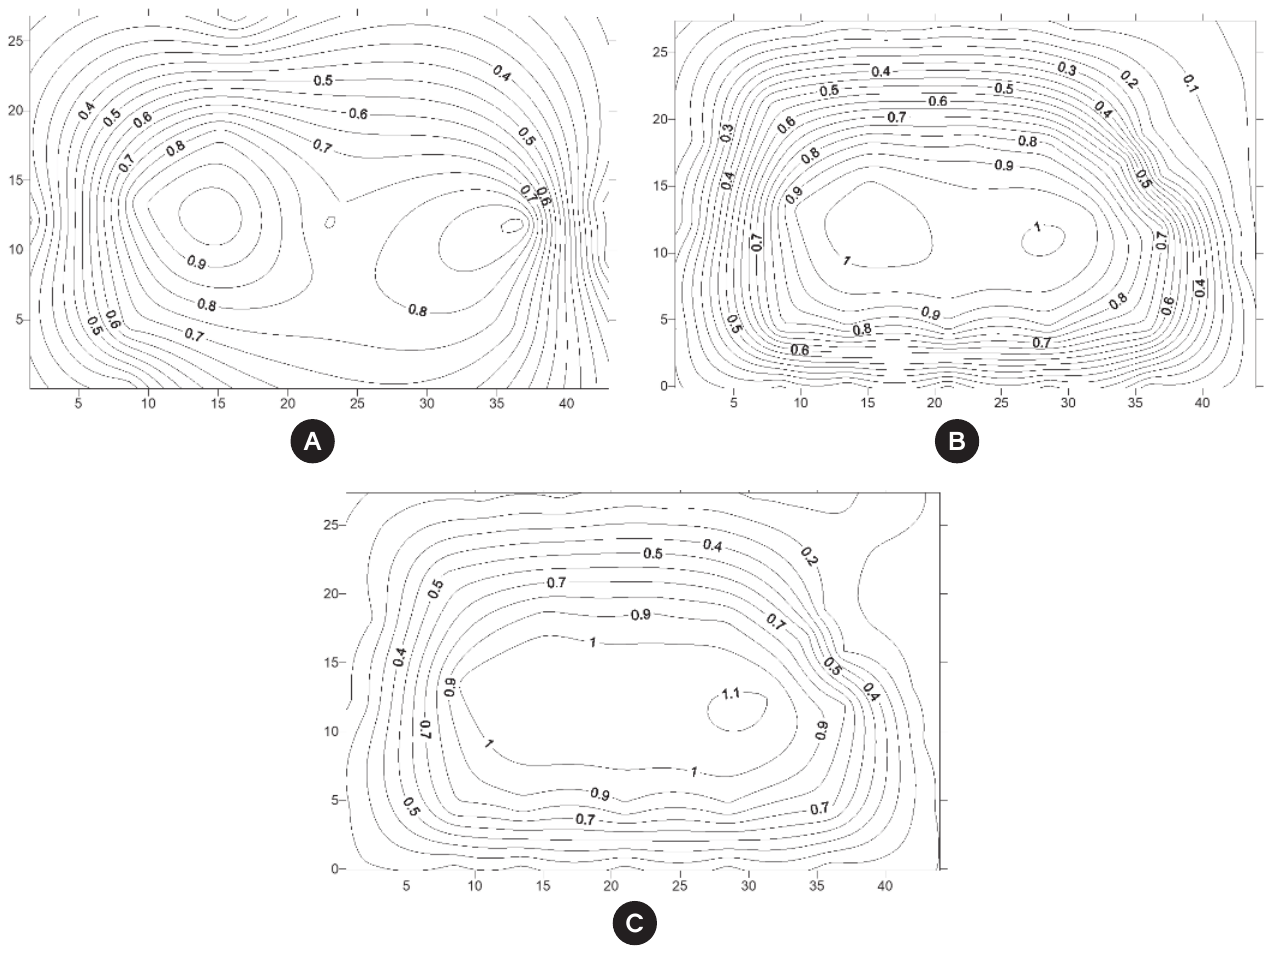
Figura 13 Curvas iso-recalques da 6 a etapa: (a) medidos, (b) calculados e (c) considerando fluência e retração (em centímetros)